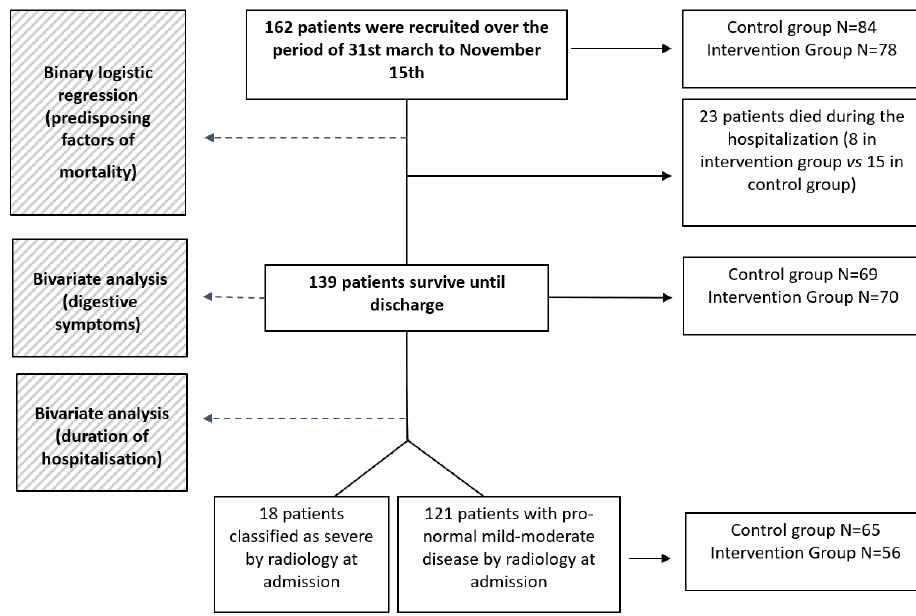
Figure 1. Workflow diagram of the patient recruitment and data analysis scheme.